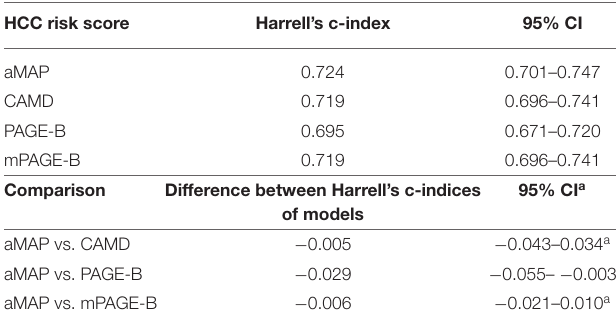
TABLE 3 | Comparison of the predictive performances of HCC risk scores at